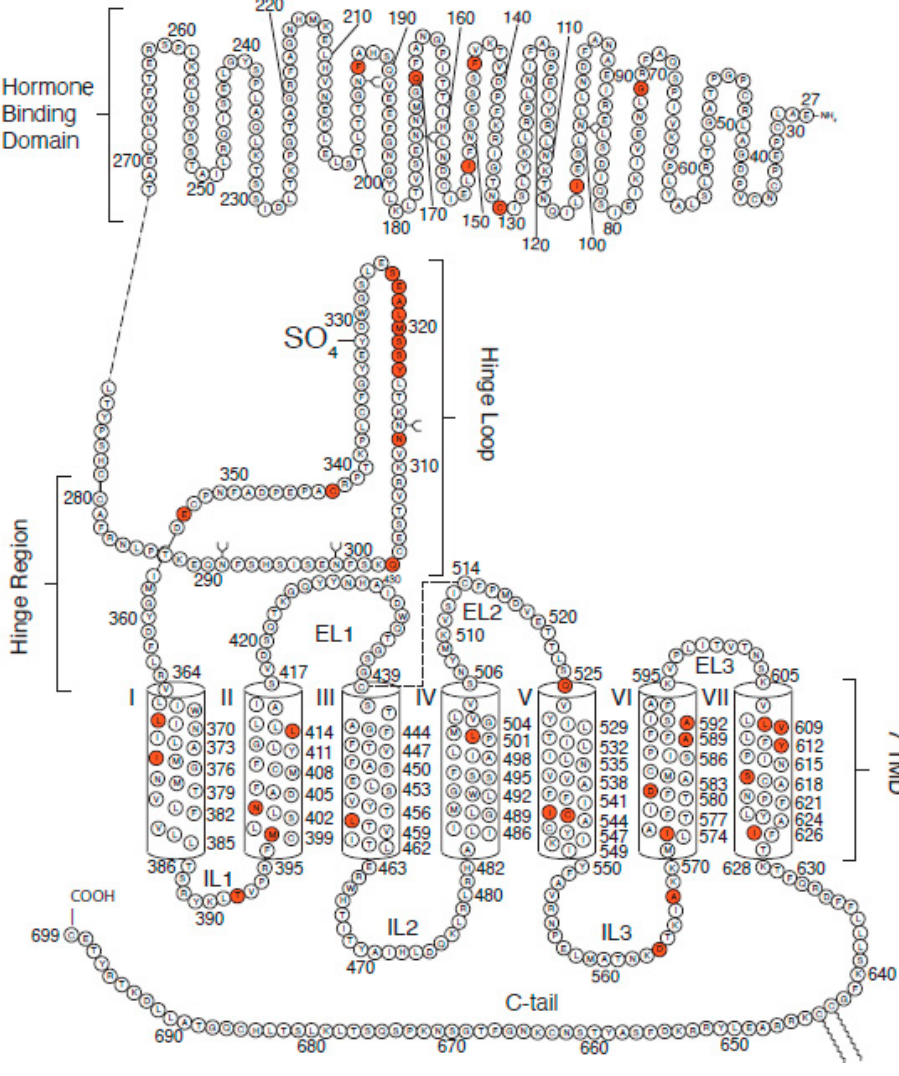
Figure 1. Structure of luteinizing hormone receptors (LHRs) showing the hormone-binding domain, the hinge region and the hinge loop, the seven transmembrane domains, and the intracellular C terminus. Mutations to amino acids shaded in red lead to LHRs loss of function. Seven transmembrane α helices, connected by three extracellular loops and three intracellular loops, make up the transmembrane domain. Each α helical segment has about 25 amino acid residues [1,5], sufficient to span the plasma membrane lipid bilayer. Cysteine residues in the first and second extracellular loops that form disulfide bridges and the overall hinge region structure appear to stabilize the seven transmembrane α helices [16]. Conformational changes occurring in the seven transmembrane domains, after receptor activation by hormone binding, are translated across the